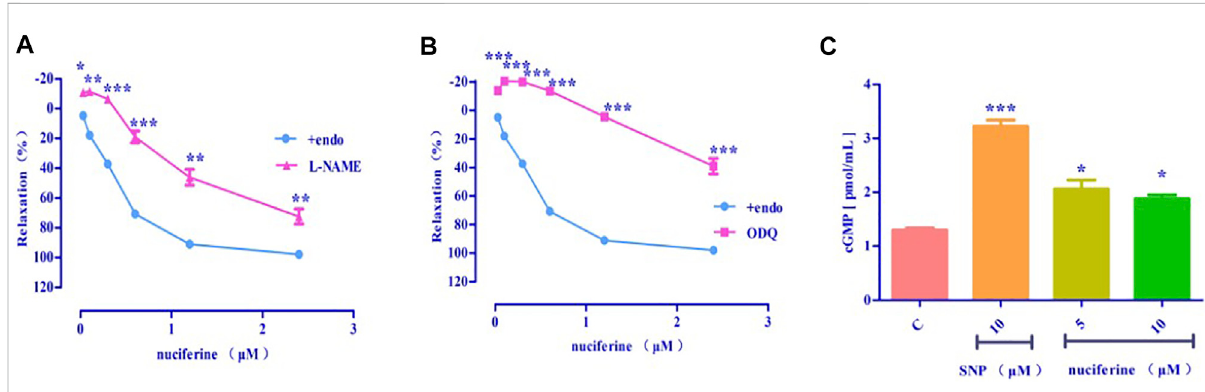
Effect of eNOS/sGC/cGMP on nuciferine-induced relaxation (A) L -NAME blocking effect; (B) ODQ blocking effect; (C) Detection of cGMP content. The data are expressed as the means ± SD of 6 – 8 rats ( n = 6 – 8). (* p < 0.05, ** p < 0.01 and *** p < 0.001 vs. control